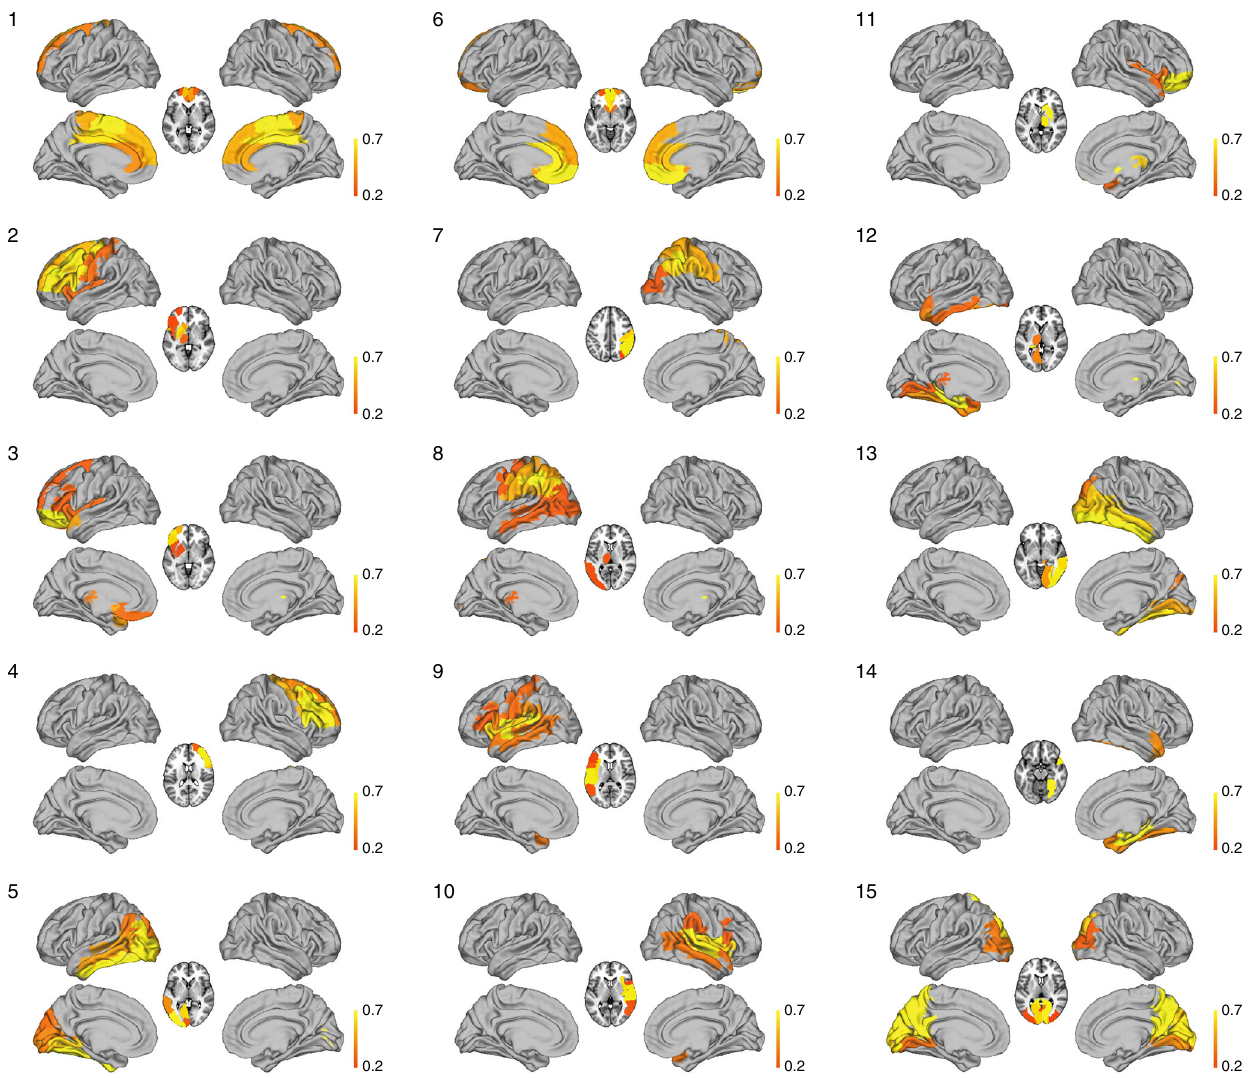
Fig. 4 Individual spacetime motifs at 200 ms rendered on the standard brain. Some of these brain networks resemble known resting state networks, e.g. networks 6 and 15, which correspond to the frontal part of the default mode network and the visual network, respectively. The other networks resemble sub-components and lateralised versions of the classical resting state networks, namely: 1. medial cingulate, 2. left orbitofrontal, 3. left prefrontal, 4. right prefrontal, 5. left higher order visual areas, 6. frontal DMN, 7. right parietal, 8. left parietal, 9. left auditory and insula, 10. right STG, auditory and insula, 11. right orbitofrontal, 12. left hippocampus, 13. right higher order visual areas, 14. right hippocampus, 15. visual